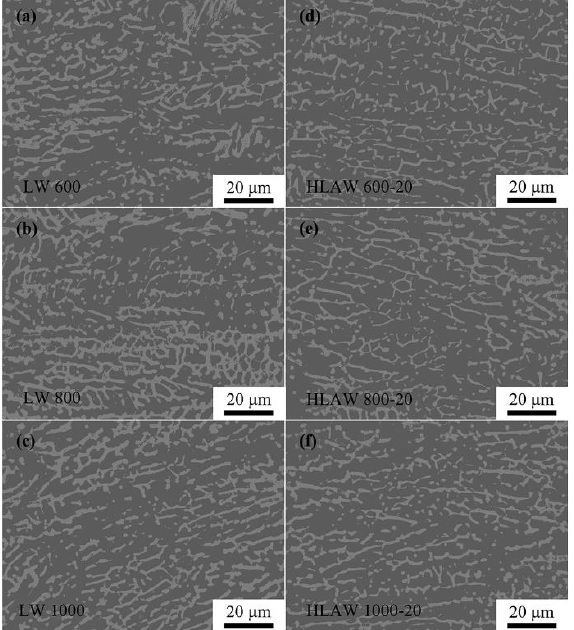
Figure 8. Microstructure image of the welding material obtained from an optical microscope and processed by image J: ( a – c ) LW 600, LW 800, and LW 1000, respectively; ( d – f ) HLAW 600-20, HLAW 800-20, and HLAW 1000-20, respectively.